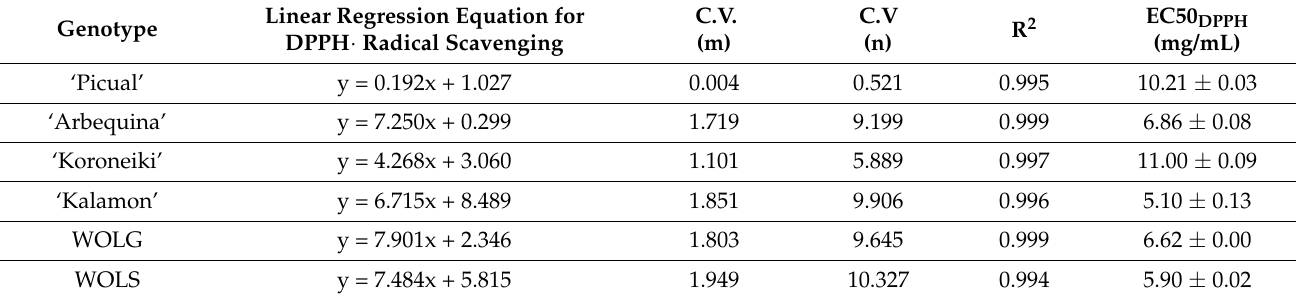
Table 2. Half maximal effective concentration as EC50 DPPH in olive leaves.